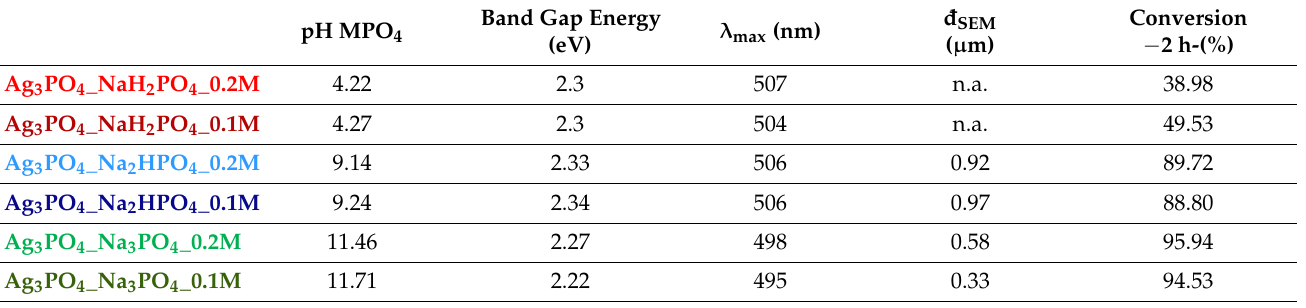
Table 1. pH, band gap energy, absorption band maxima, average particles sizes, and conversion values of the obtained Ag 3 PO 4 samples (n.a.—no